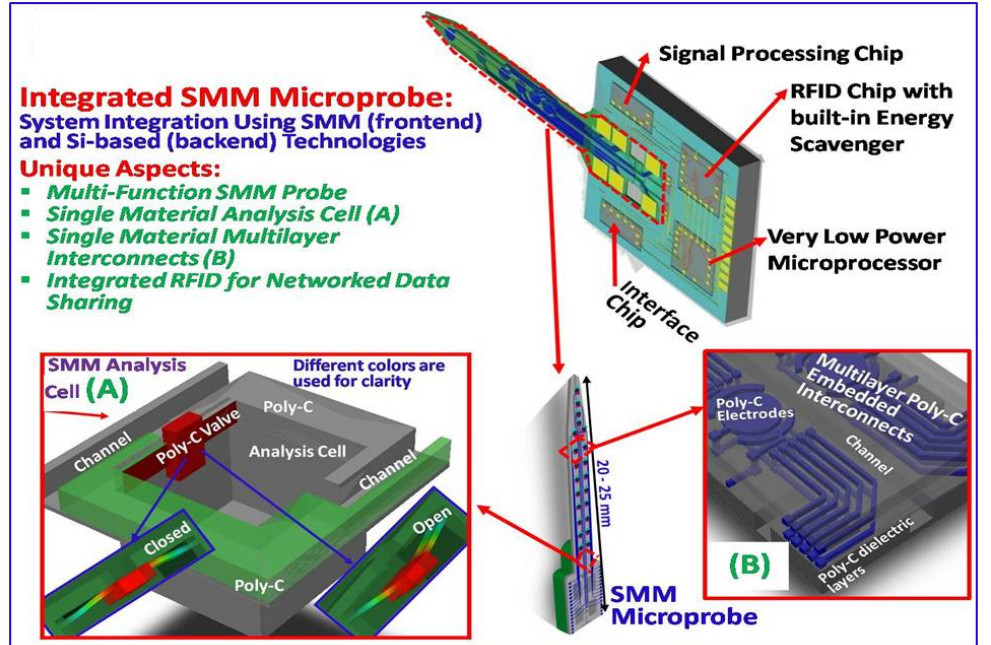
Figure 1. Concept diagrams for multi-functional integrated microsystems for